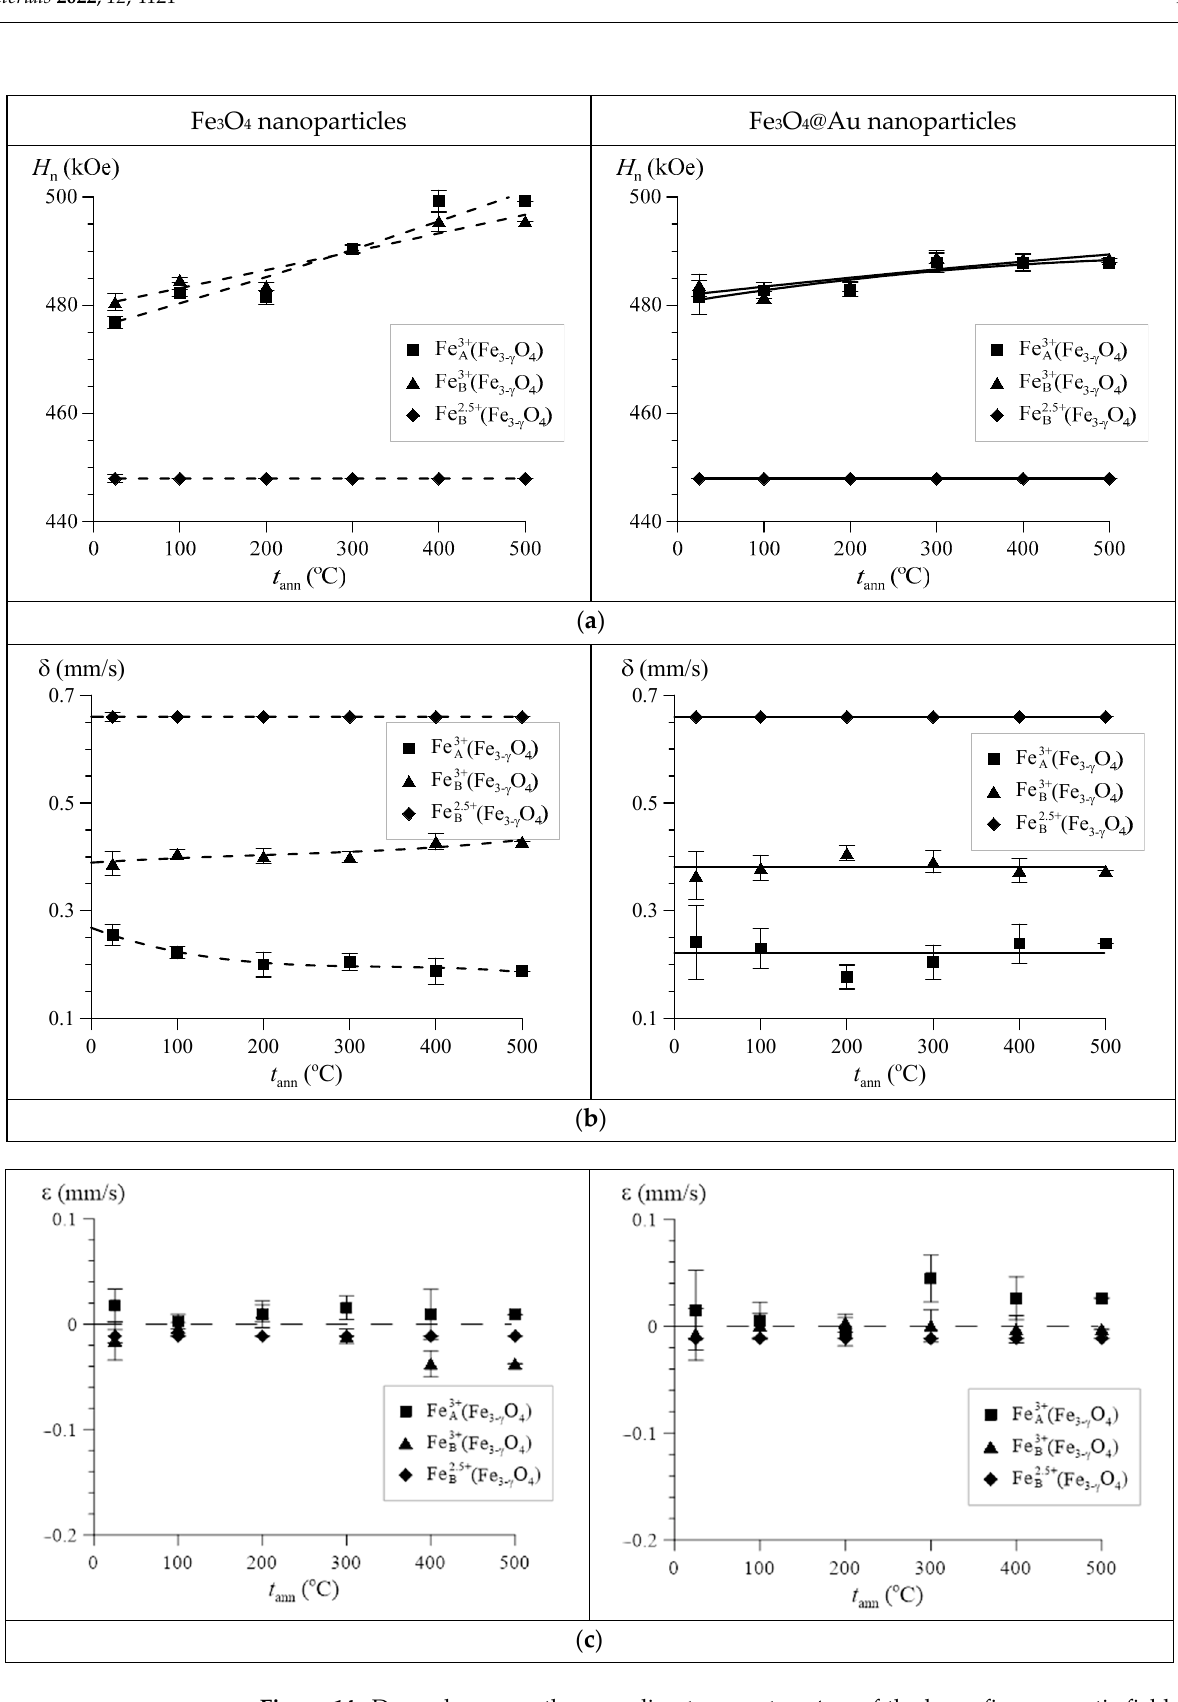
Figure 14. Dependences on the annealing temperature t ann of the hyperfine magnetic field H n ( a ), the isomer shift δ ( b ), and the quadrupole shift ɛ ( c ) for nonstoichiometric magnetite in Fe 3 O 4 and Fe 3 O 4 @Au nanoparticles.